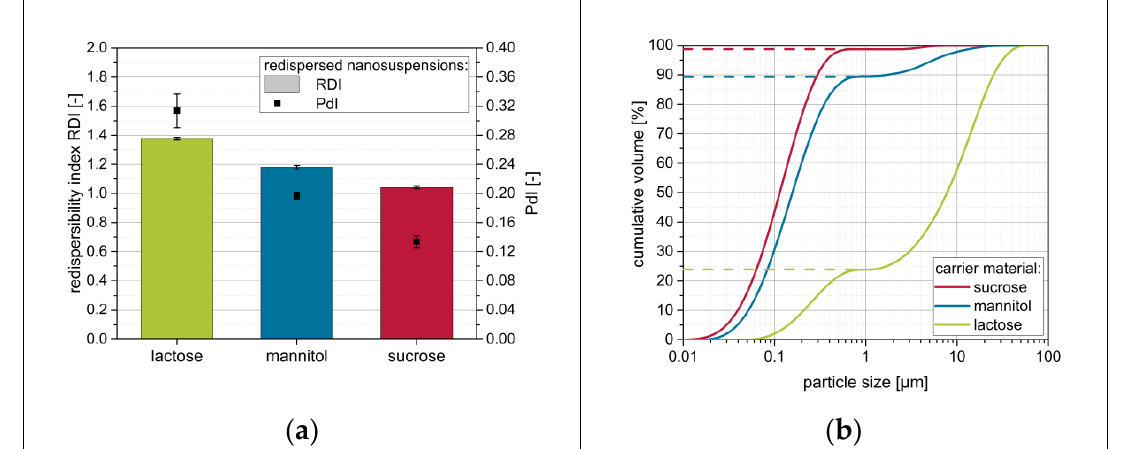
Figure 2. Influence of the carrier particle type on the redispersibility of granules produced with a naproxen nanosuspension without additional drying excipients (except the stabilizing polymer PVP/VA). Measurements were carried out by means of ( a ) DLS and ( b ) LD (dashed lines refer to extracted redispersed volume factions).